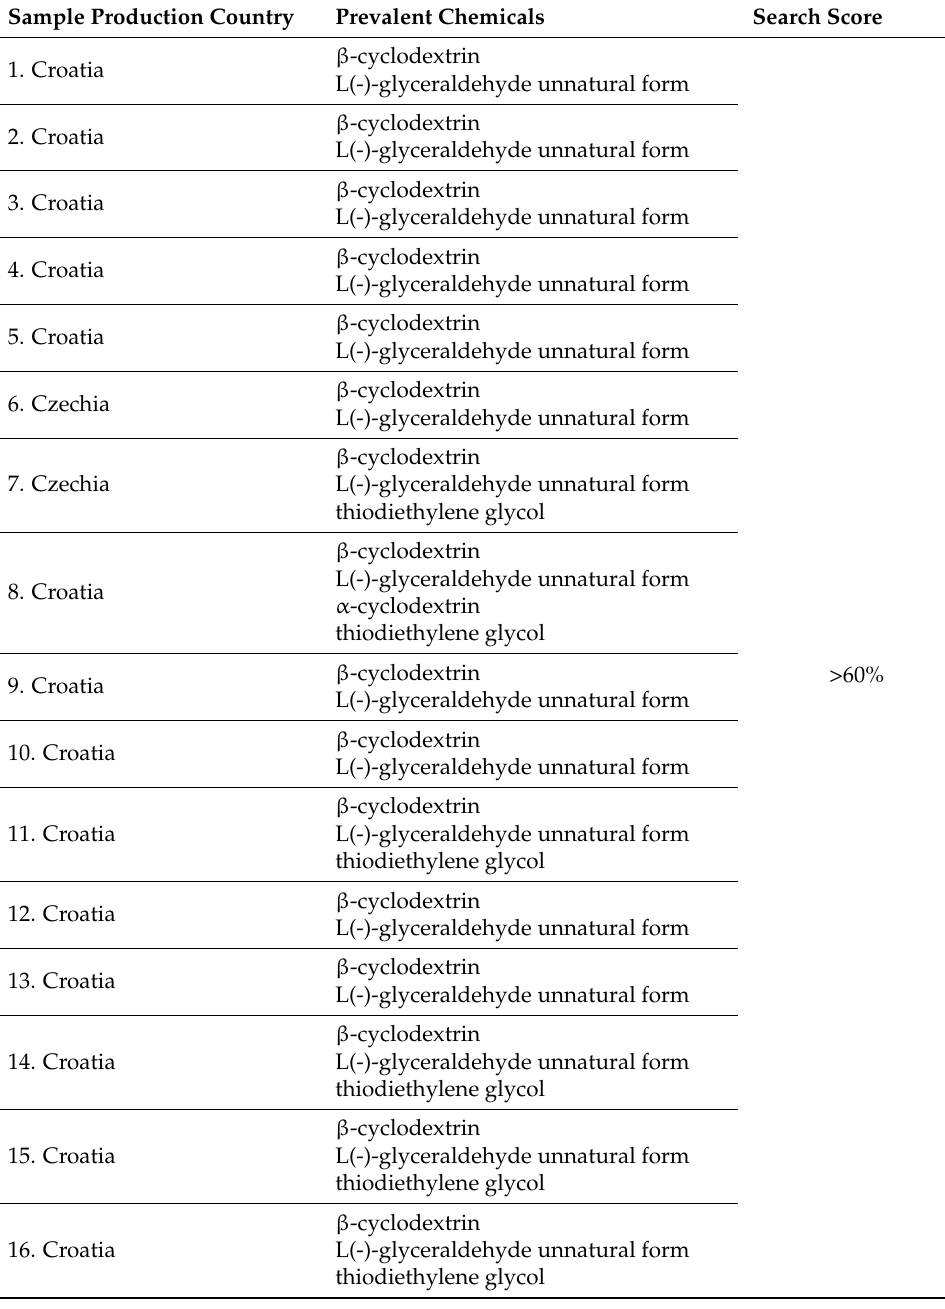
Table 2. Search scores above 60% for analyzed